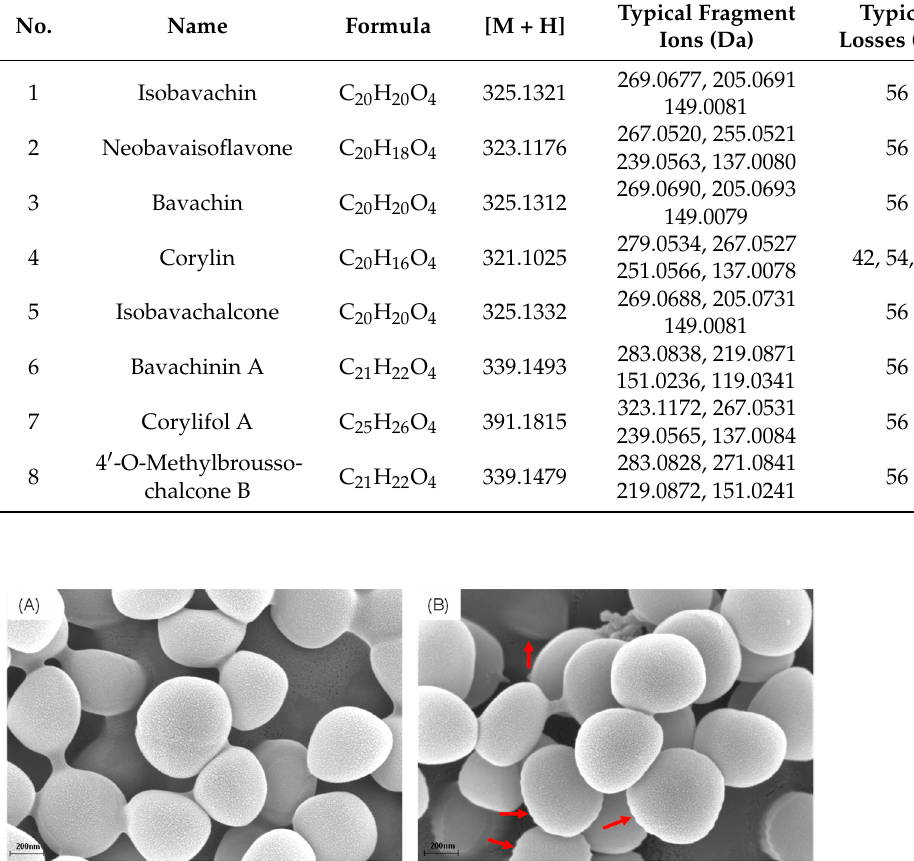
Figure 3. Bacterial morphology affected by Fr. A in the ( A ) control group and ( B ) treatment group.